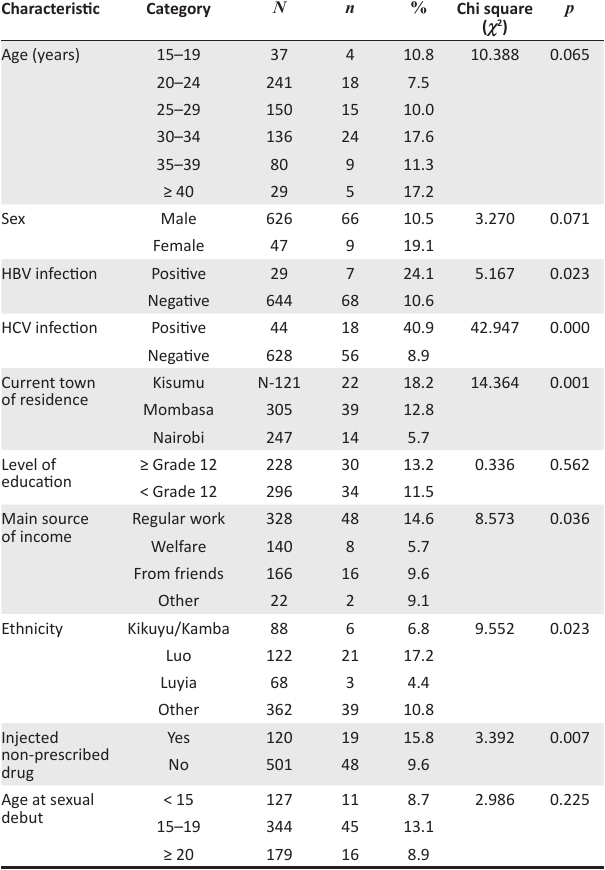
TABLE 2: Predictors of human immunodeficiency virus infection among drug users from three major cities in Kenya.